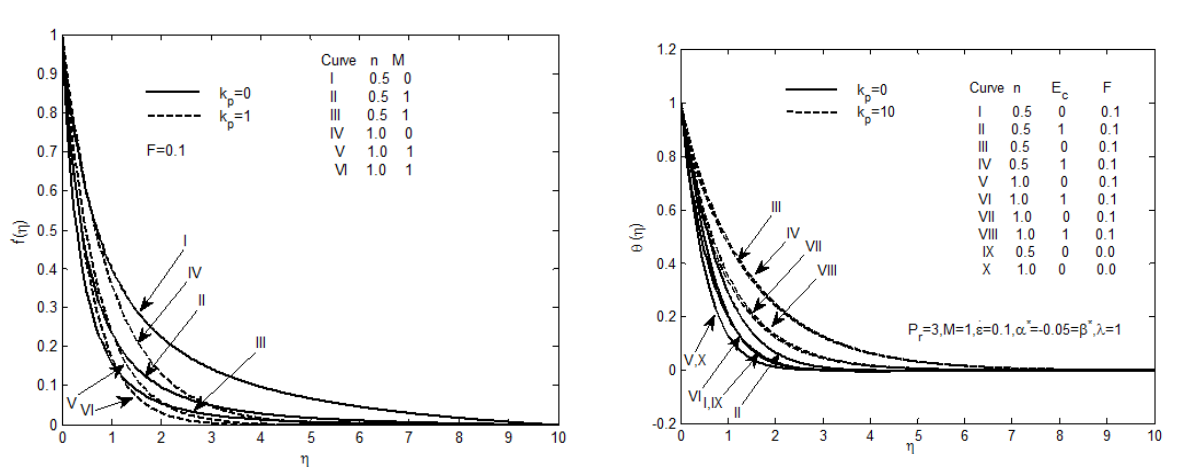
Figure 5: Horizontal velocity profiles